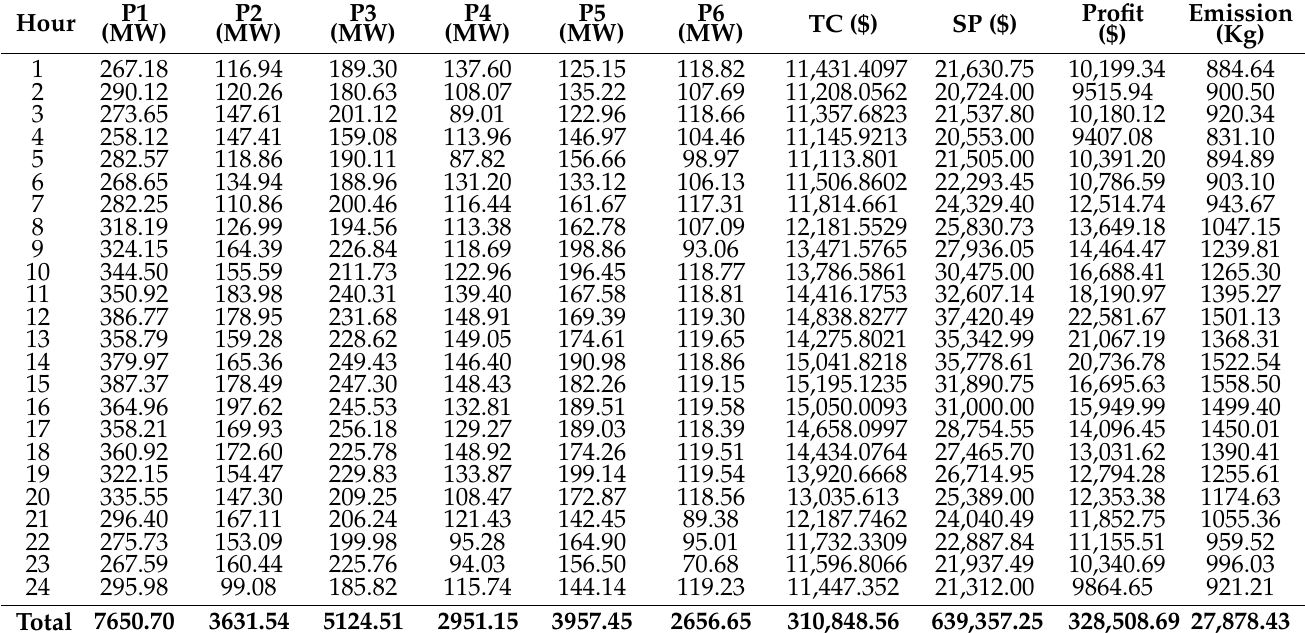
Table 6. Optimal generation schedule, cost, selling price and profit for Test Case 1 (Best Compromise Solution).